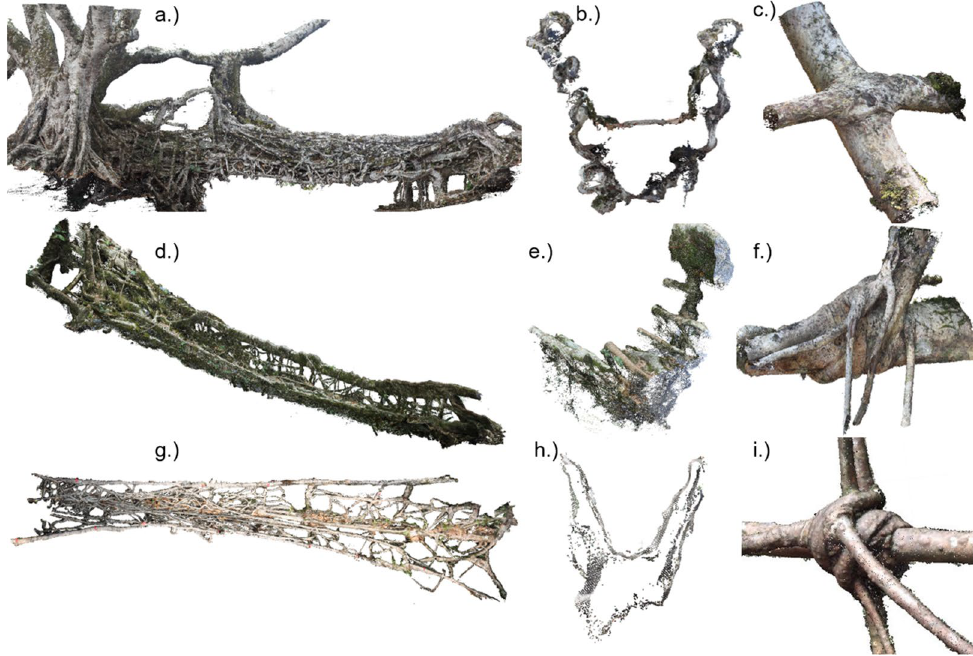
Figure 4. The photogrammetric surveys of living root bridges resulted in PCs of differing quality. ( a ) and ( b ) show the generally complete Nongbareh bridge; ( d ) and ( e ) show Niah Li bridge, relatively complete on the top, missing details on the underside; ( g ) shows the details captured on the top of Kudeng Rim bridge, missing perspectives from underneath - shown by areas of low point density in ( h ). ( c ), ( f ) and ( i ) are details from other